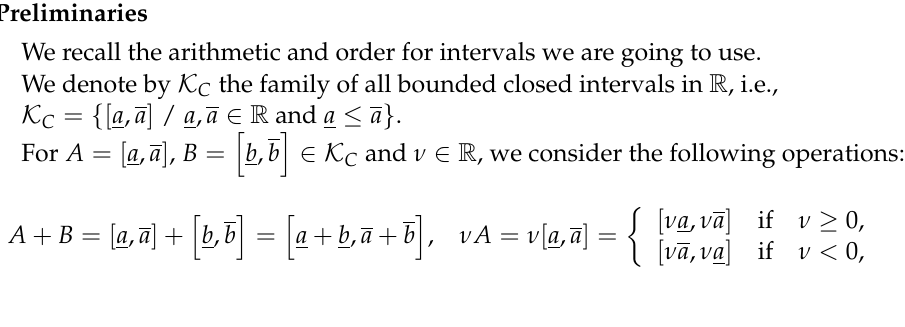
Figure 3. Sequencing of